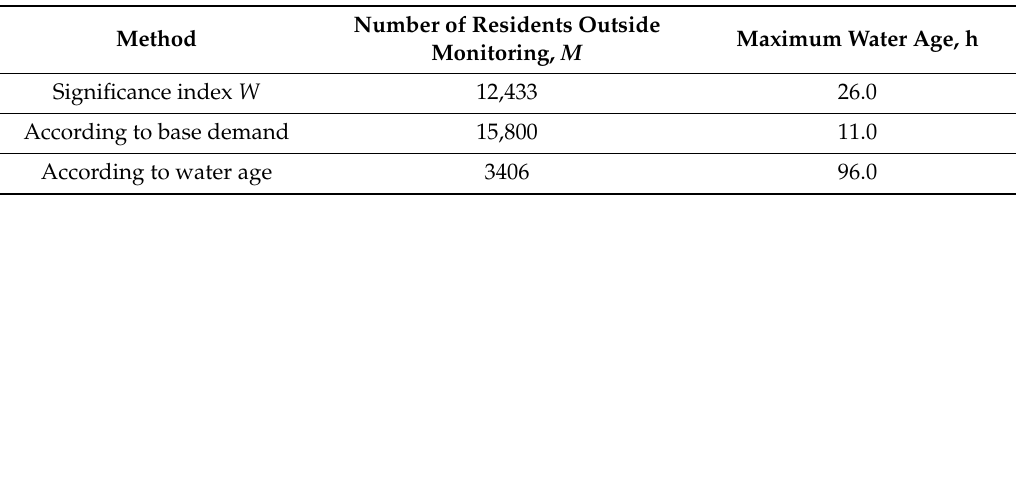
Table 8. Approximate number of residents outside the monitoring of free chlorine and maximum water age for the designated measurement